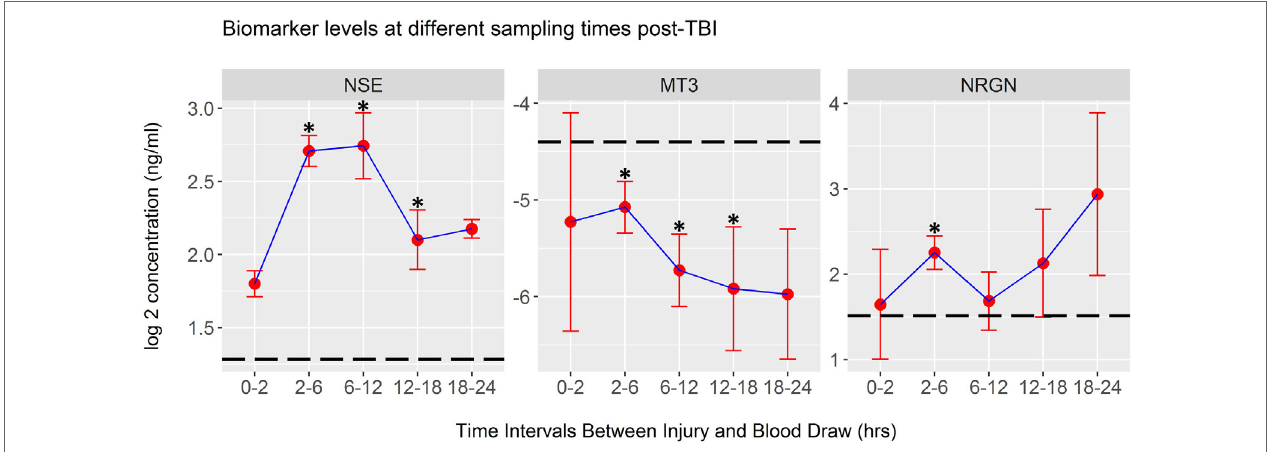
FigUre 4 | Biomarker concentrations detected at different post-injury time intervals. Plots of log2-transformed mean serum levels for ACRM + mild TBI (mTBI) patients (red dots) are plotted with the SEM (whiskers). Significant changes were seen in neuron-specific enolase (NSE) levels between time intervals (Kruskal–Wallis Test, p < 0.01), whereas metallothionein 3 (MT3) and neurogranin (NRGN) were not significantly different ( p = 0.56 and 0.63, respectively). Differences between the mean of the healthy control population and each mTBI biomarker level were tested at each time interval. Significant changes were demonstrated at multiple time points for each marker, determined by univariate analysis in logistic regression (asterisks on each plot, p < 0.05; dotted line, mean for 328 healthy controls; whiskers,